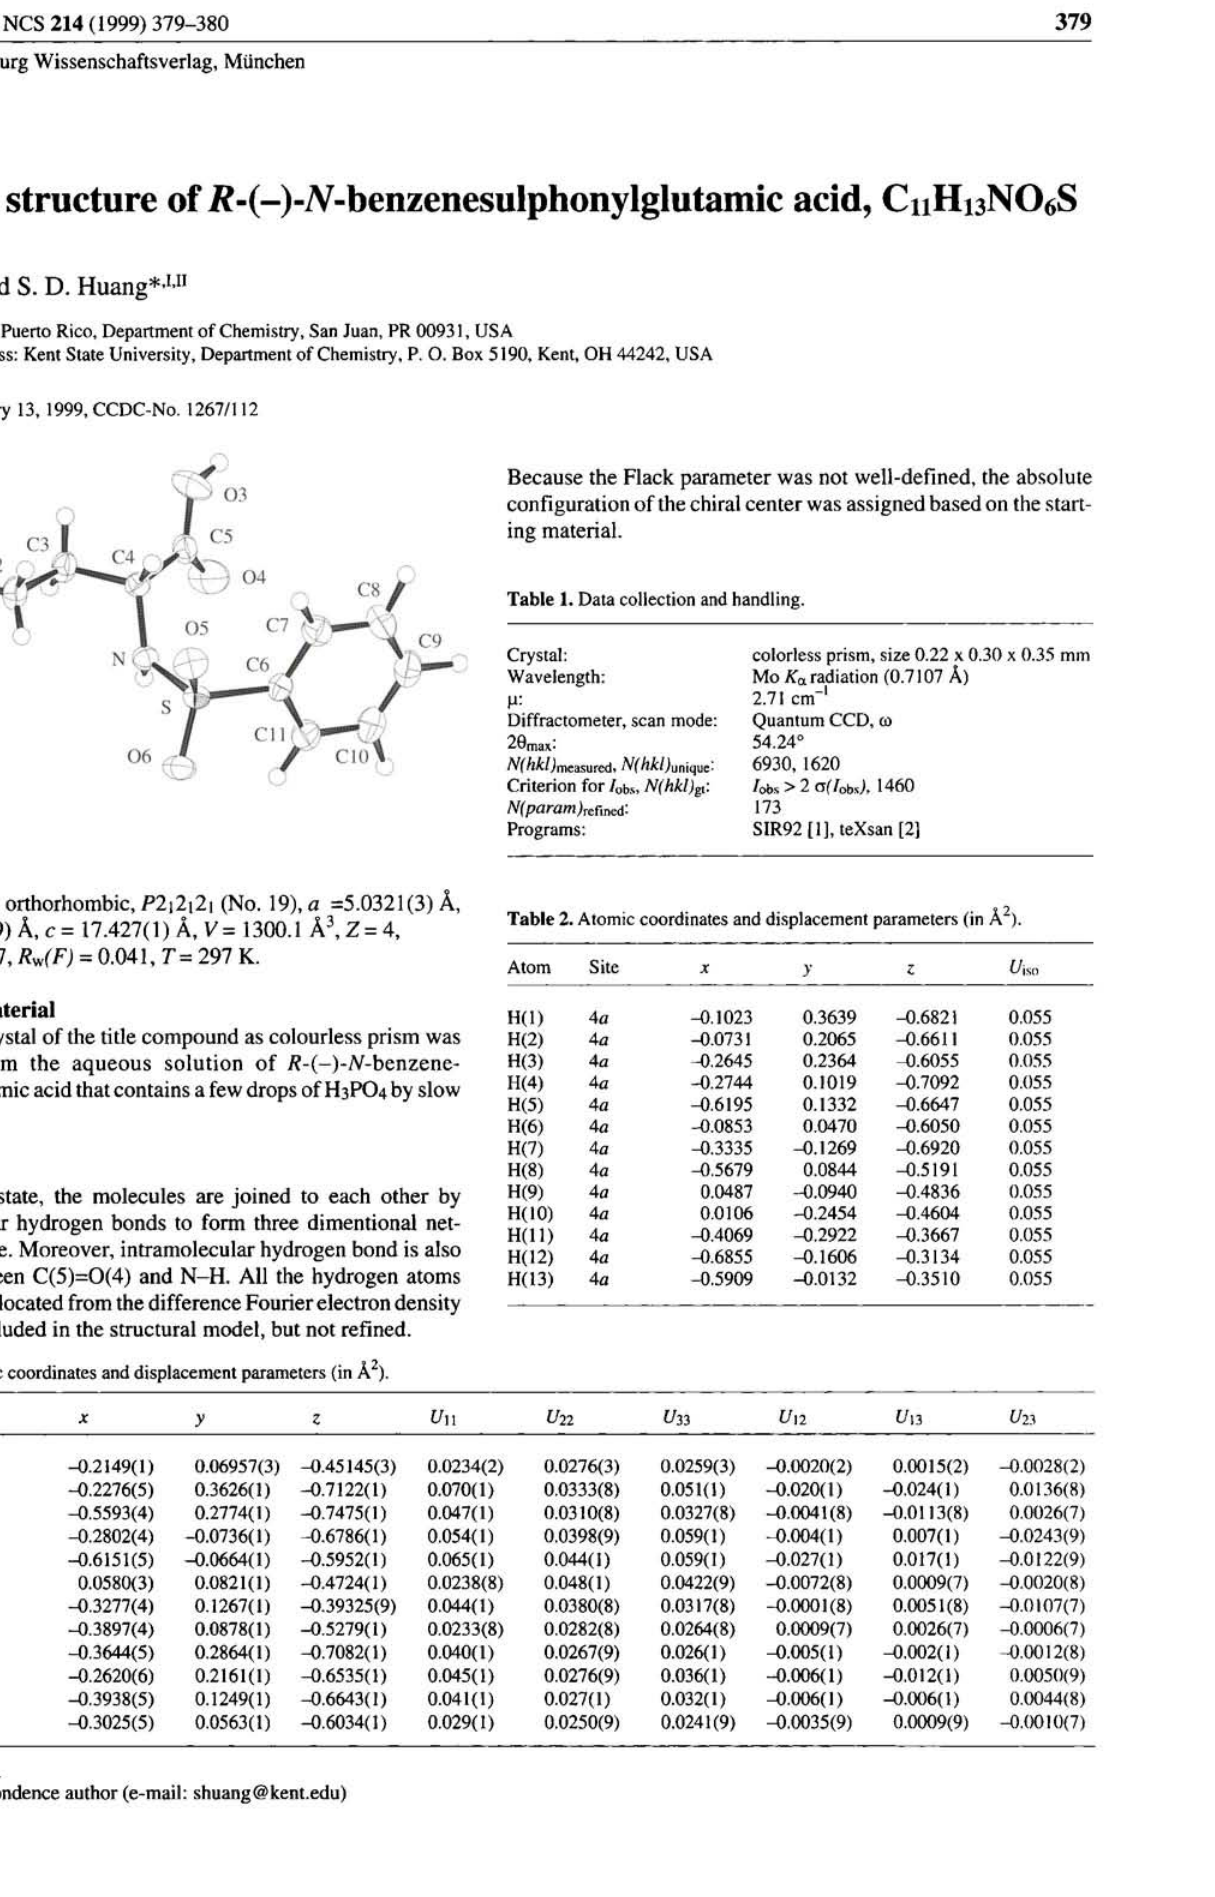
Table 1. Data collection and handling.